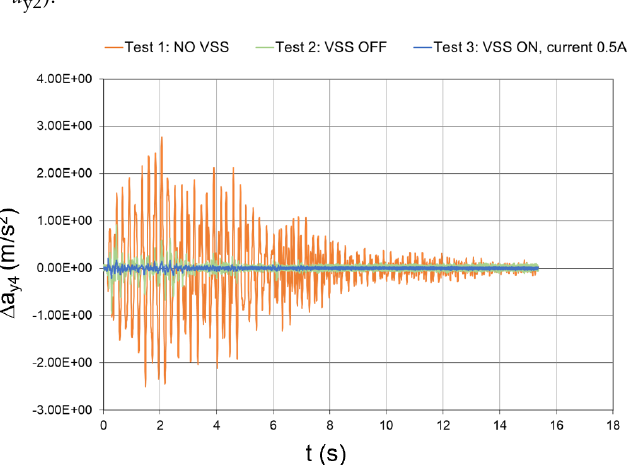
Figure 51. Seismic response (experimental data), interstory acceleration at the 3rd floor ( Δ 𝑎 y3 = 𝑎 y3 − 𝑎 y2 ).